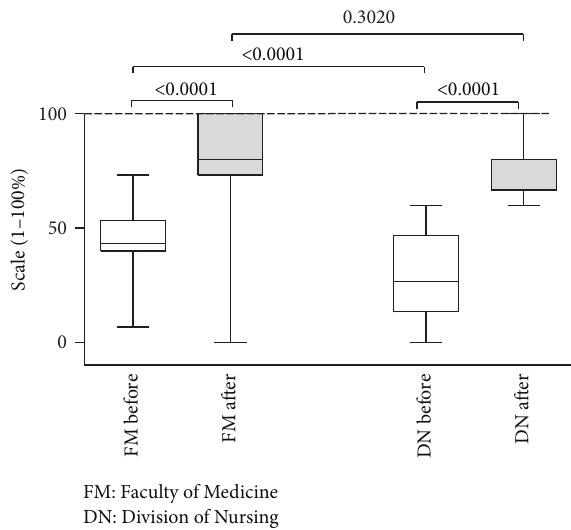
Figure 1: The level of knowledge of Faculty of Medicine students (left panel) and Division of Nursing students (right panel) before and after completion of the obligatory